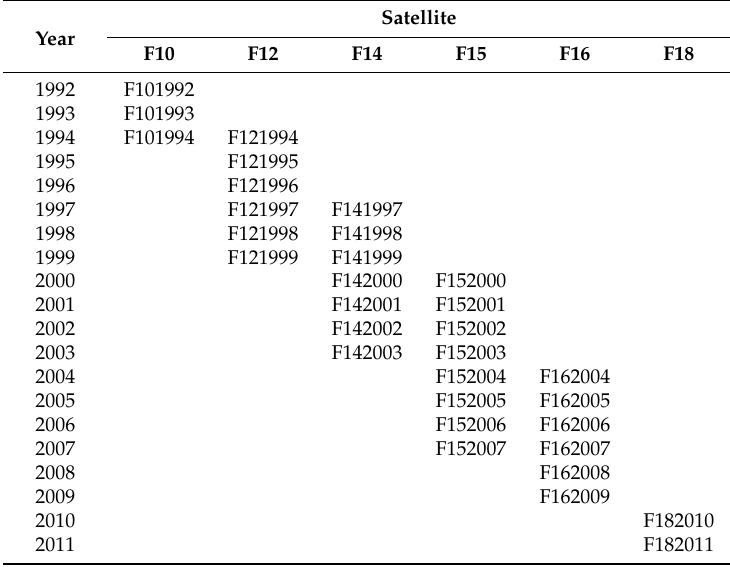
Table 1. Set of annual composites from several satellites for the years